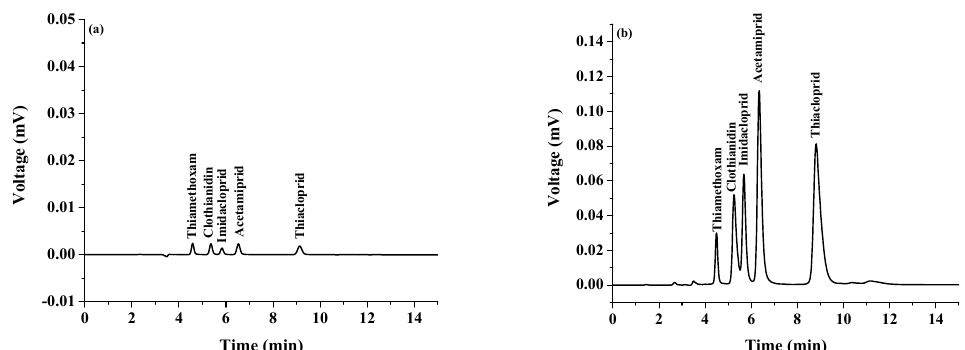
Figure 5. Chromatogram of standard neonicotinoids obtained by ( a ) without preconcentration and ( b ) with β -cyclodextrin-LLME-SFO procedure: concentration of all standards was 0.50 µg mL − 1 .